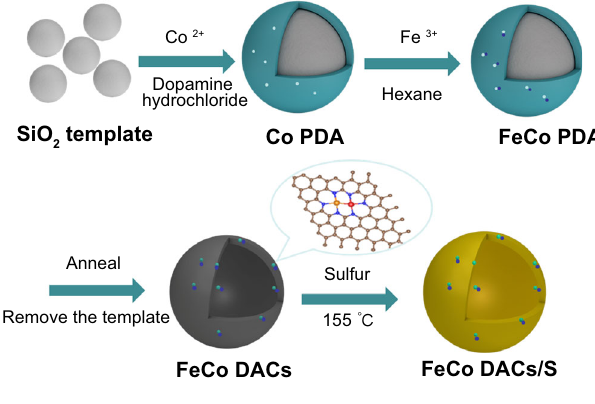
Fig. 1 | Synthesis scheme. Synthesis scheme of Fe-Co DACs and Fe-Co